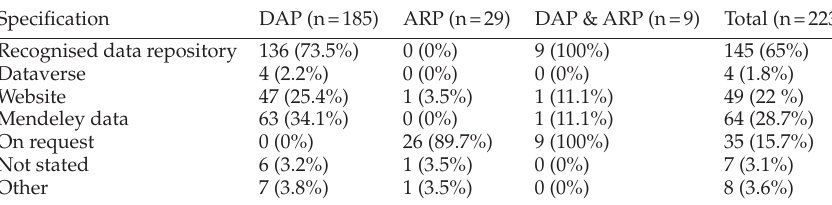
Table 2: Recommendations for depositing and disclosure of research data and replication files made by journals (multiple answers